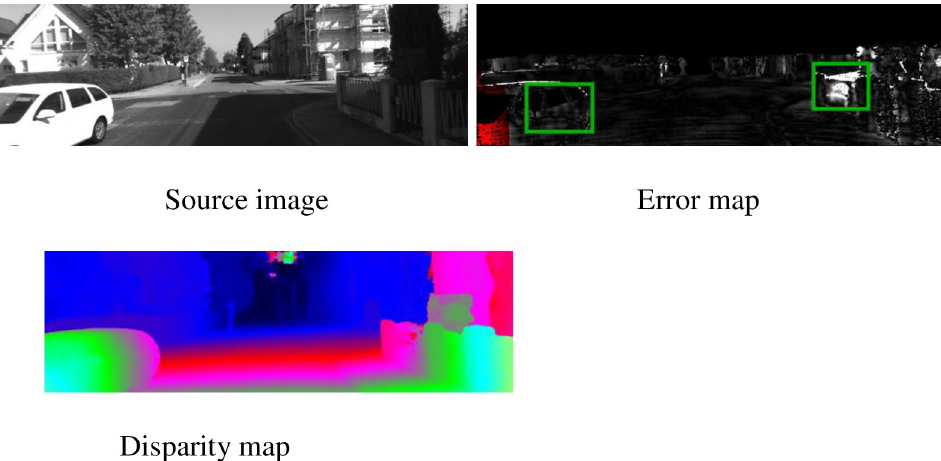
Fig 1. The disparity estimation results of the PSMNet algorithm in the ill-conditioned region. The error map scales linearly between 0 (black) and 5 (white) pixel errors. The green box in the figure shows a large error in the disparity estimation of the vehicle and wall reflection